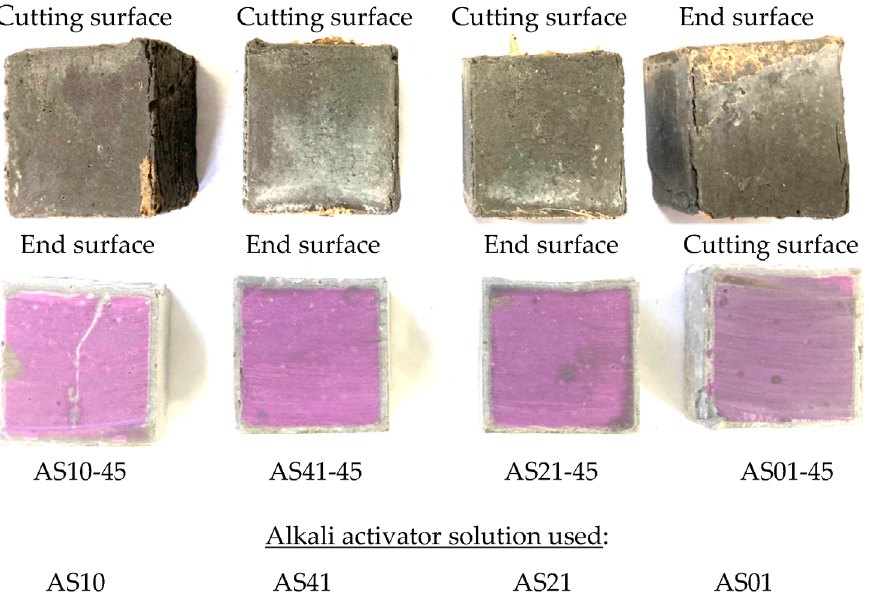
Figure 7. Appearance (upper row) and coloring (lower row) of the specimens using different AS solutions after 84-day sulfuric acid immersion.